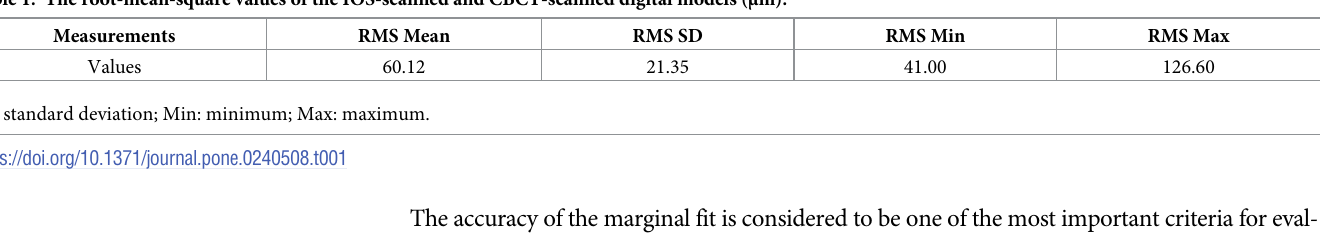
use CBCT devices, which provides a high resolution of 100 μ m or less, to obtain more accurate marginal edge information on prepared teeth. affect the marginal and internal fits of the interim crown. Although a wide range of conversion